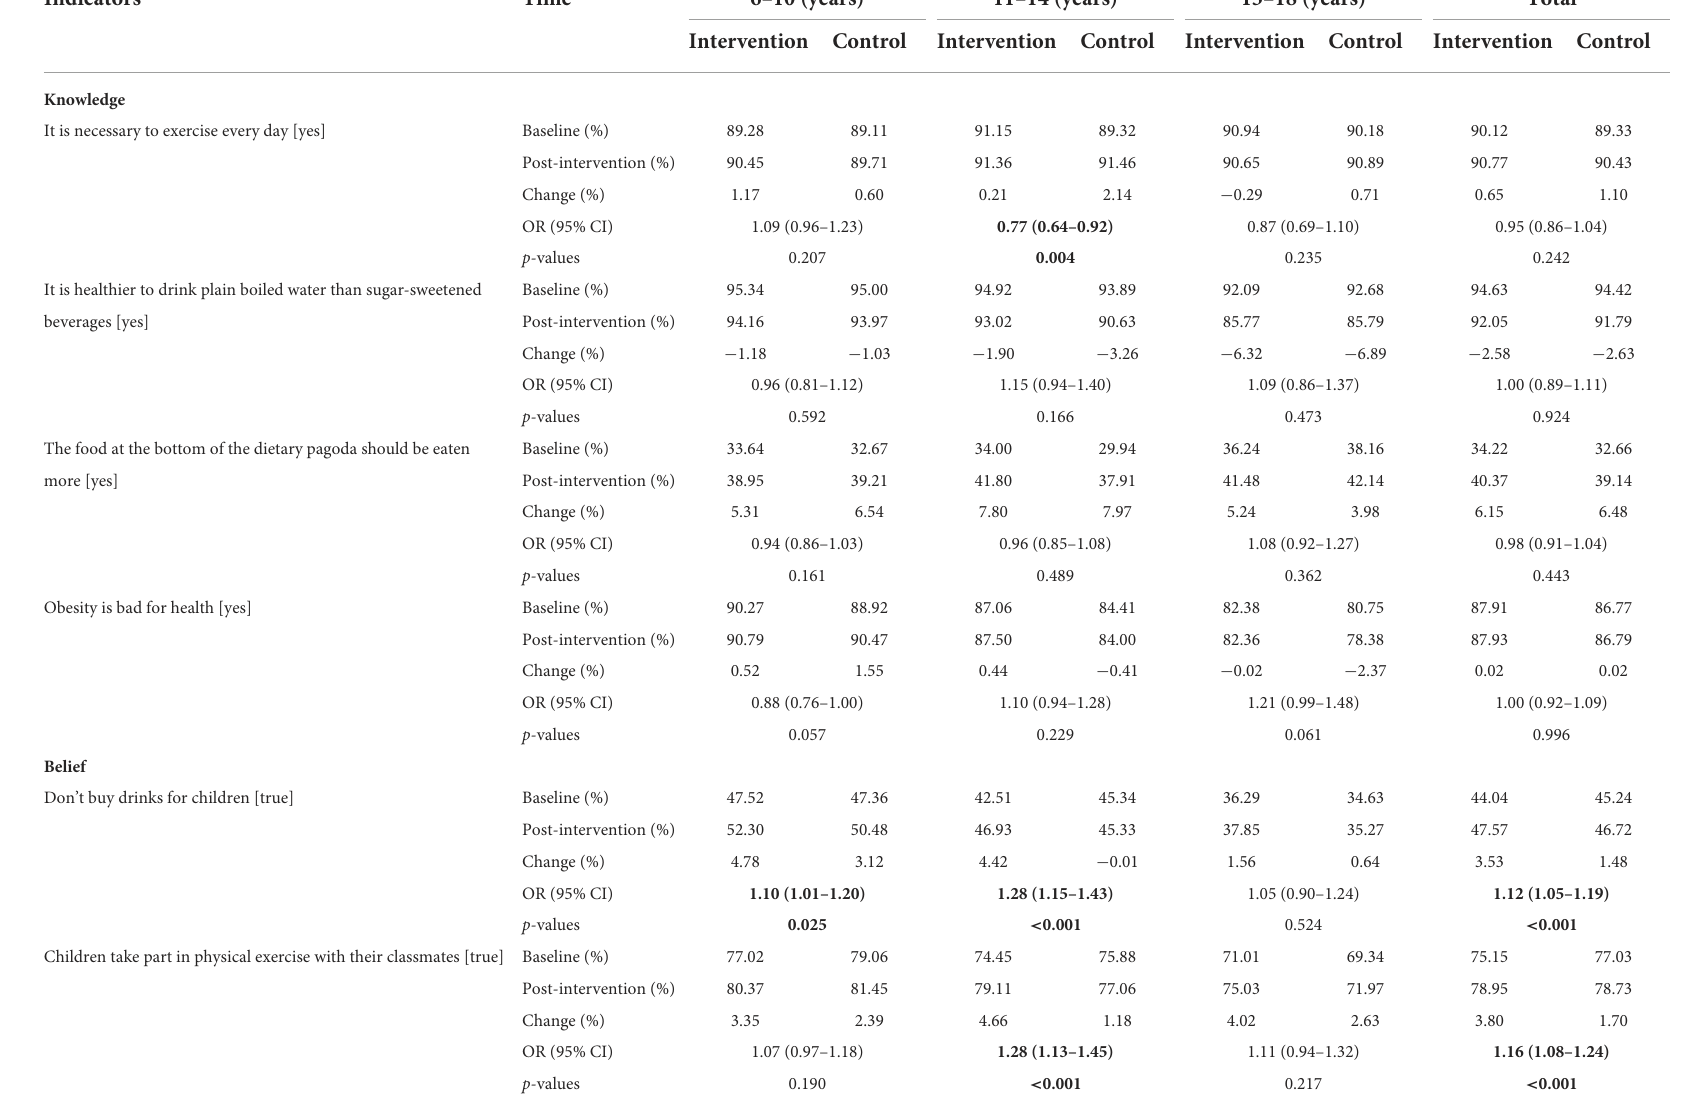
TABLE 5 Effectiveness on the parents’ knowledge, belief, and practice (by age).